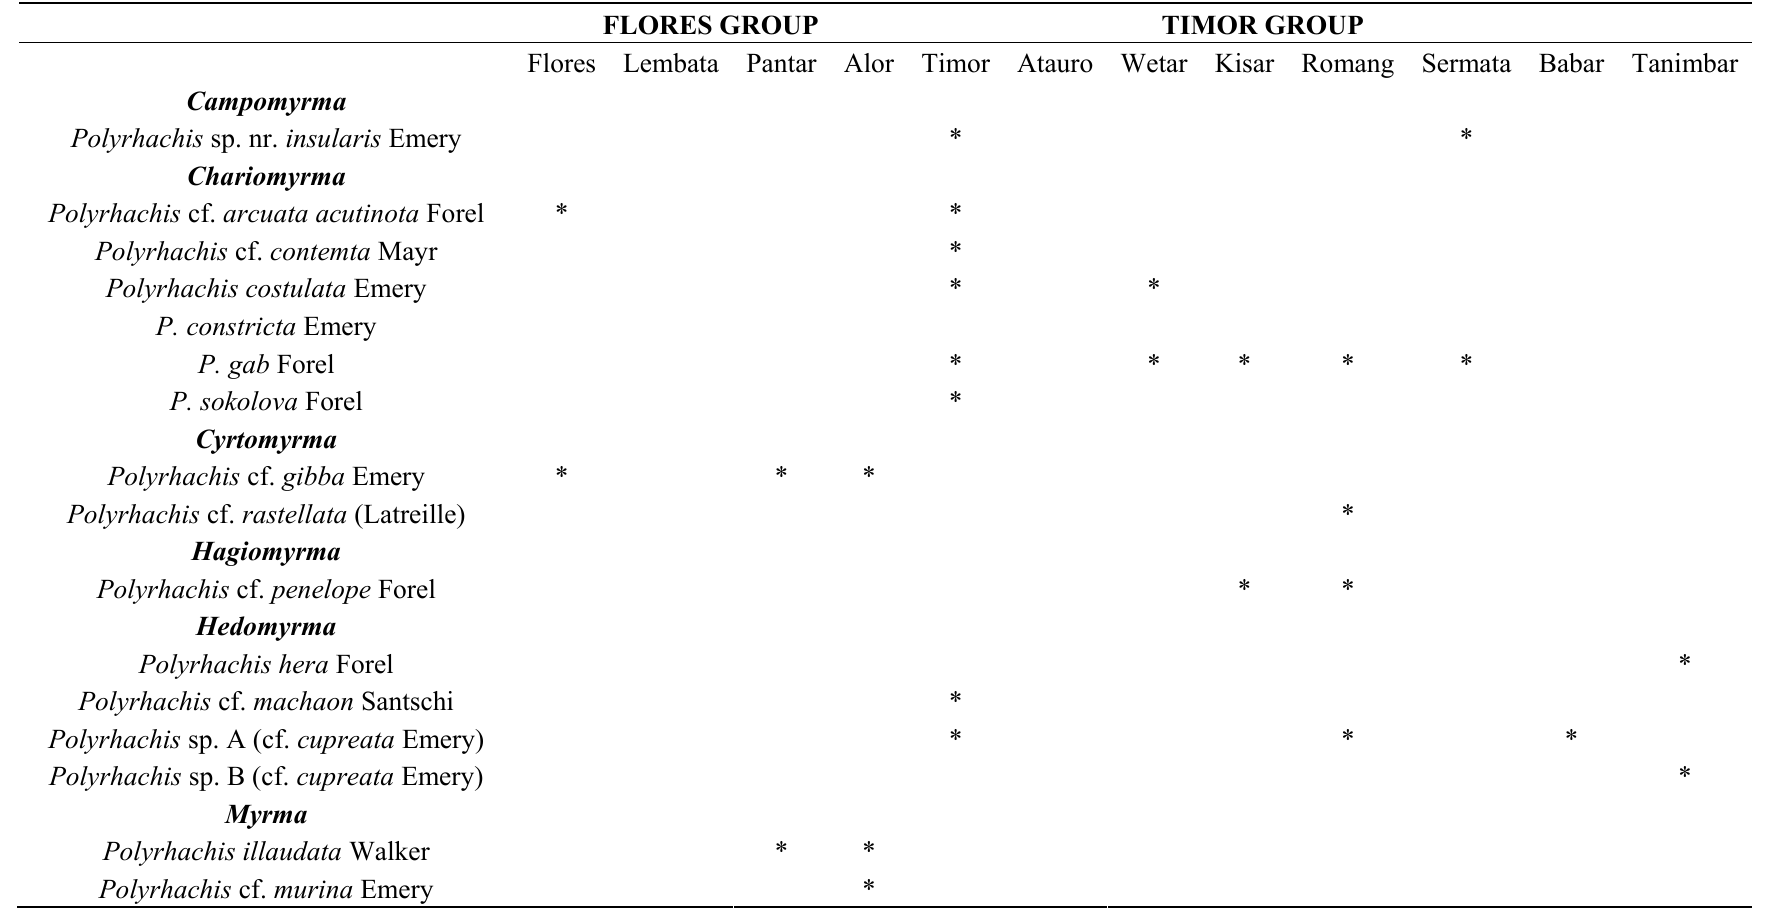
Table 2. Species of Polyrhachis recorded from Timor and surrounding islands in this study. FLORES GROUP TIMOR GROUP Flores Lembata Pantar Alor Timor Atauro Wetar Kisar Romang Sermata Babar